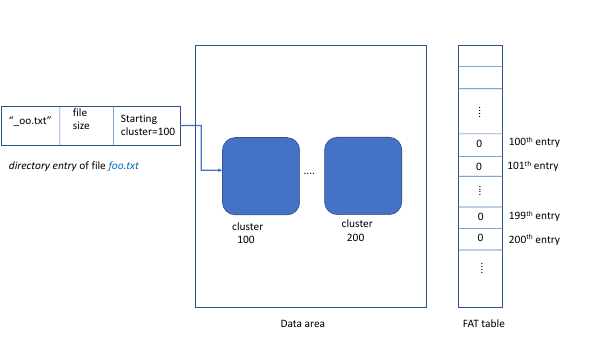
Figure 2. The metadata and actual content of foo.txt are shown after the file is deleted whereas the corresponding entries (i.e., 100-200) in the FAT table are zeroed.